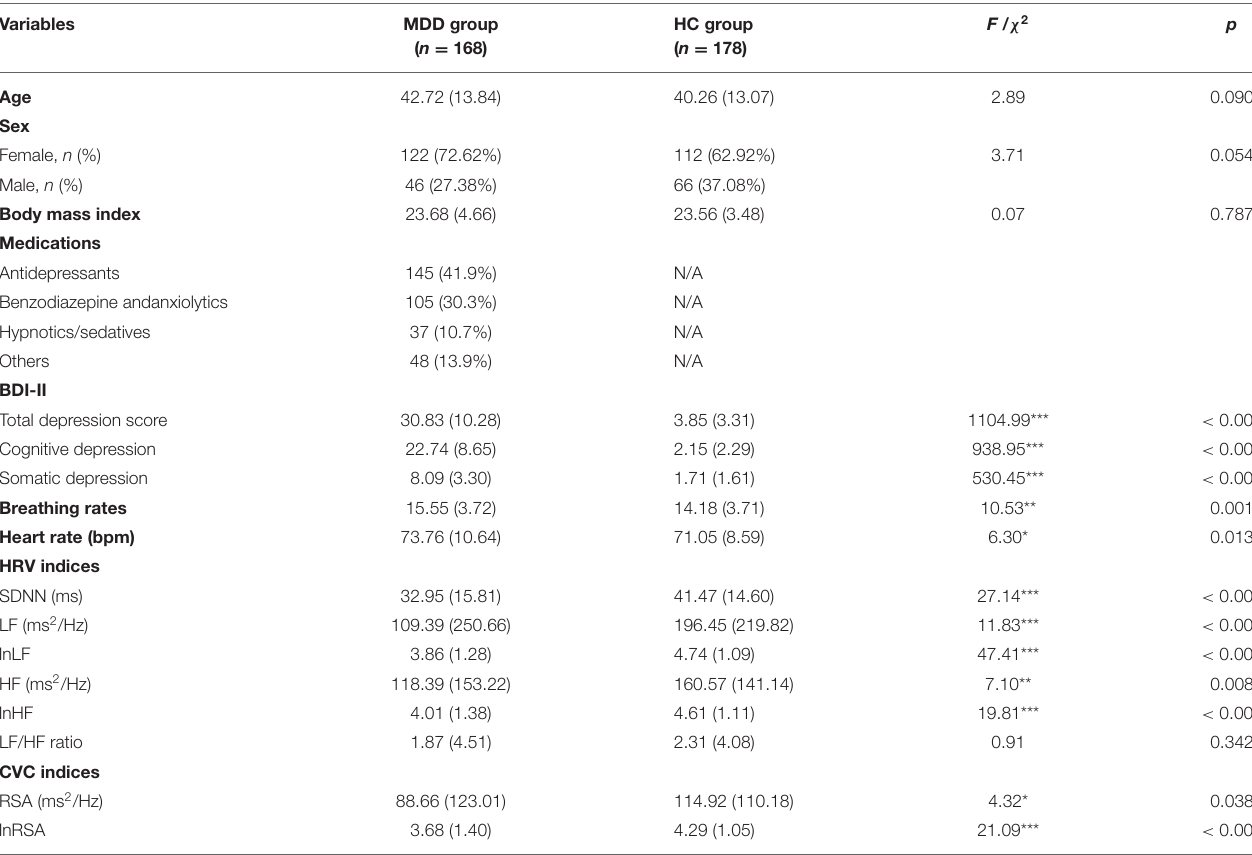
TABLE 1 | Demographic characteristics and research variables between the MDD and HC groups ( N =